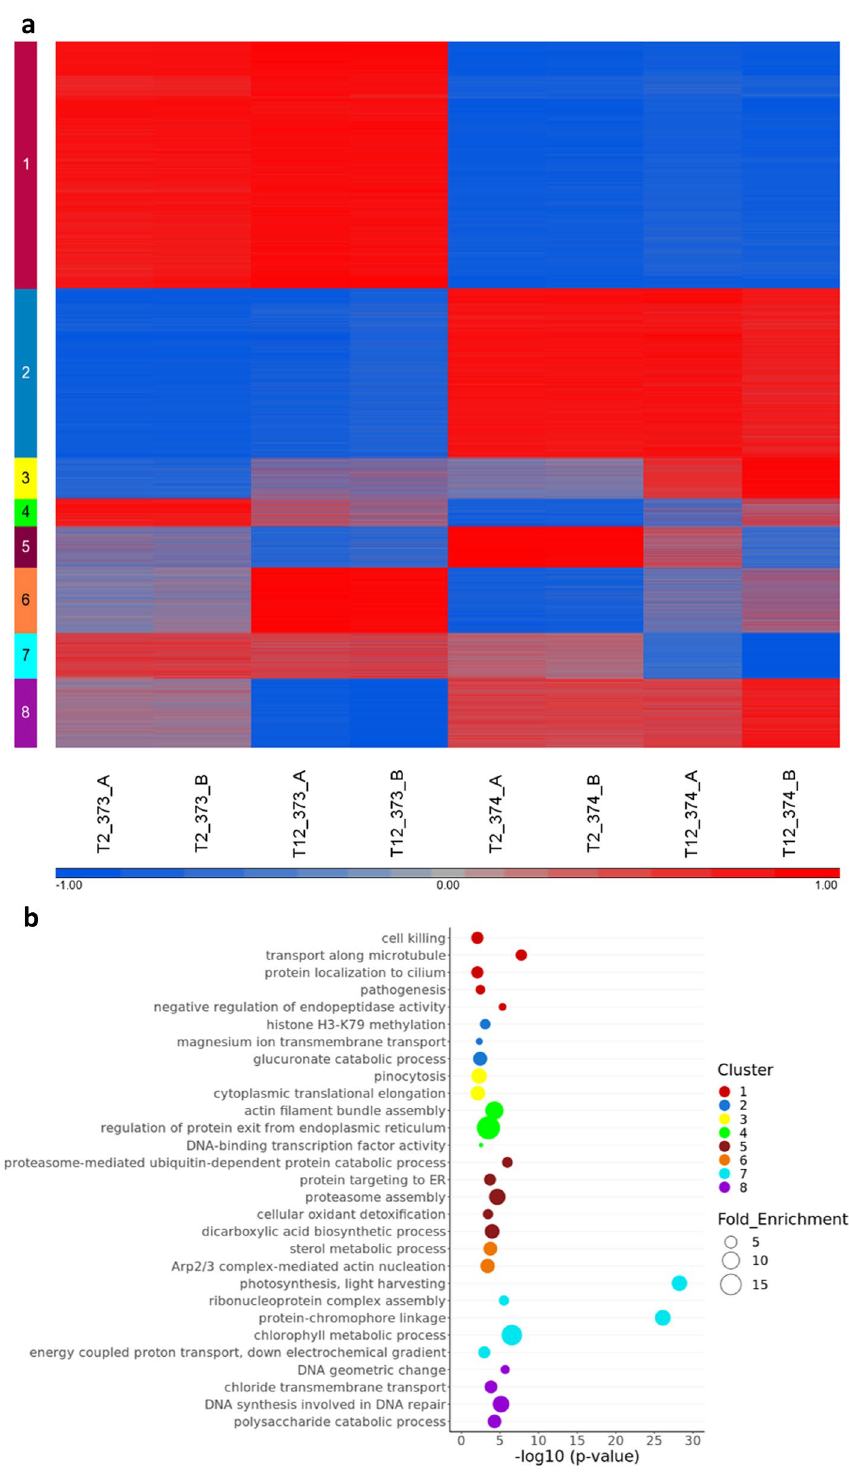
Figure 3. Global gene expression profiles of E. huxleyi: Differentially expressed loci in CCMP373-CCMP374. ( a ) K-means clustering of genes with altered expression levels between strains and growth states is presented. The expression levels are standardized by gene. T2-day 2 of growth, T12-day 12 of growth. A and B are biological replicates. Red, high expression level; blue, low expression level. ( b ) Top significantly enriched GO terms (hypergeometric test, p value < 0.05) related to gene clusters displayed in ( a ). Colors refer to clusters as indicated in ( a ). For a full list of enriched GO terms in each cluster, see Supplementary Table